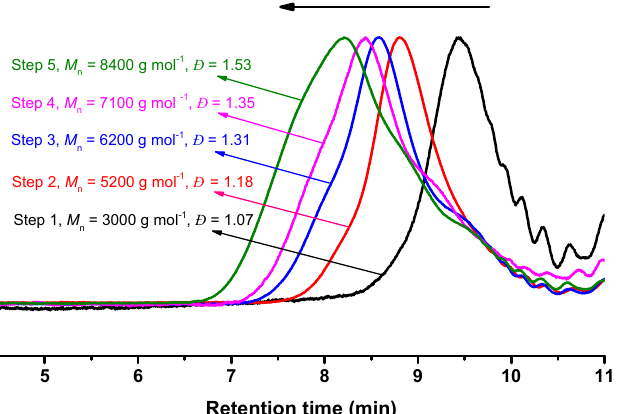
Scheme 5. Design and preparation of the block copolymer and random copolymer.